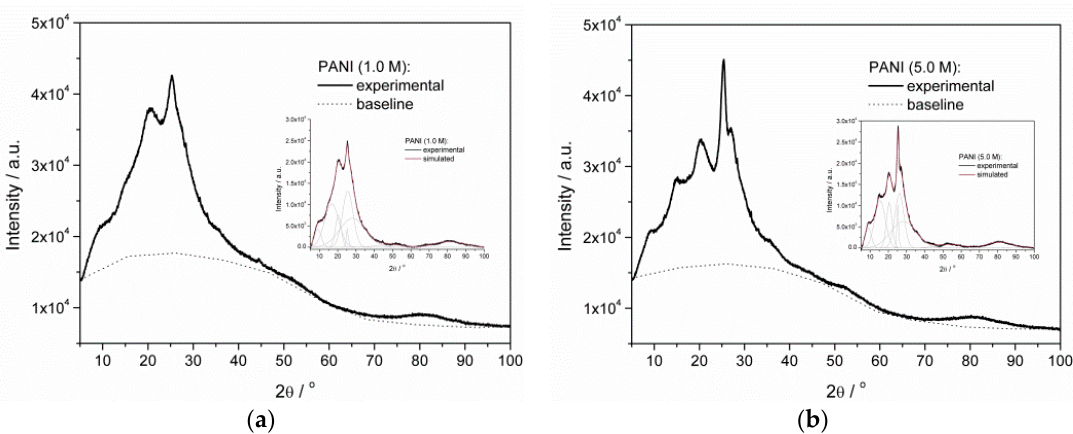
Figure 6. X-ray diffraction (XRD) pattern of doped ( a ) PANI (1.0 M) and ( b ) PANI (5.0 M) powders and spectral deconvolution (inserts).